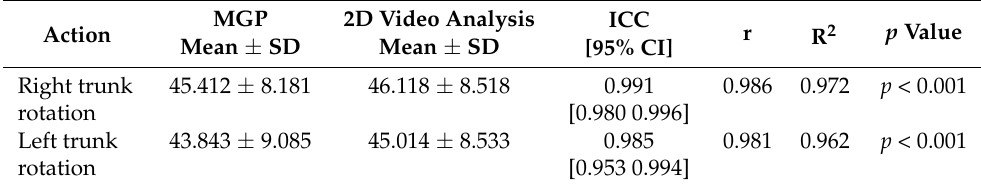
Table 3. Validity of the MGP and video analysis.